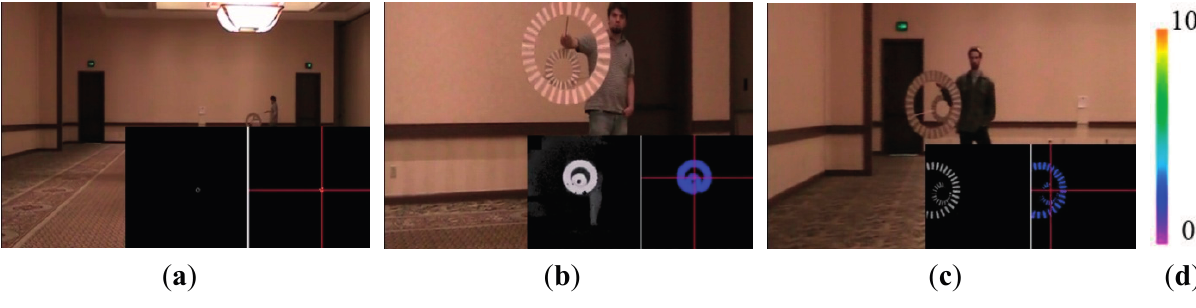
Figure 13. 2D digital camcorder and 3D Flash LIDAR camera.